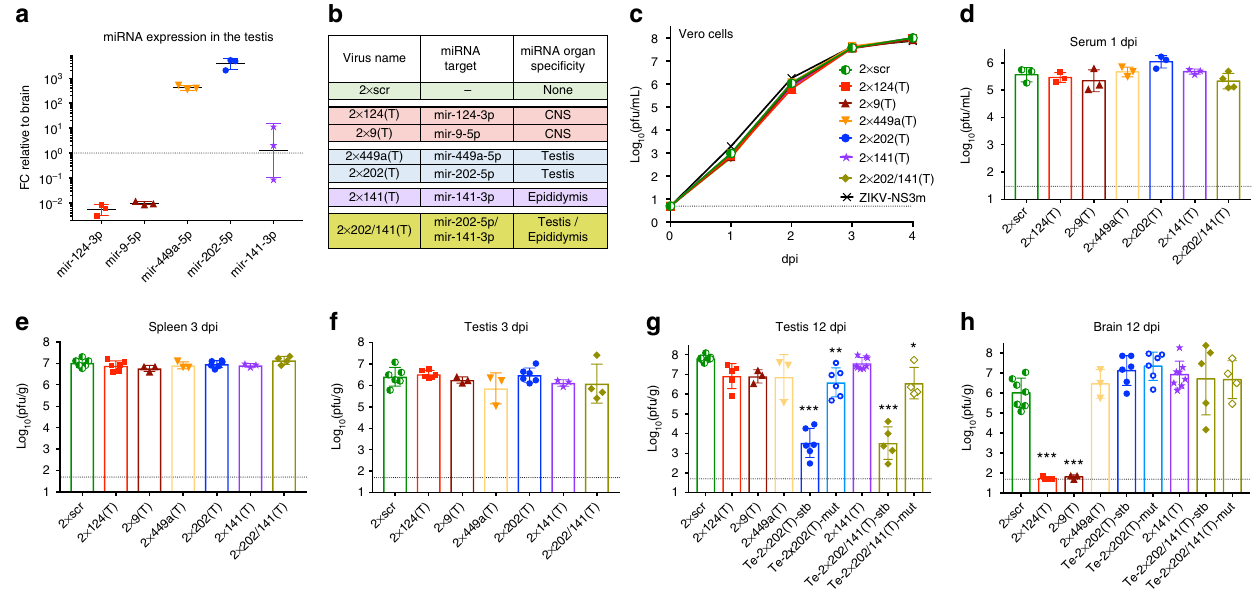
Fig. 2 Effect of miRNA target insertions on ZIKV replication in the serum and organs of AG129 mice. a Relative expression of selected miRNAs in the testis compared with their expression in the brain. Data indicate the ratio (folds change [FC]) of normalized counts for miRNAs isolated from the testis to those isolated from the brain of individual AG129 mice ( n = 3). Horizontal line and error bar are geometric mean and geometric SD, respectively. b List of viruses with inserted miRNA targets. c Growth kinetics of recombinant viruses in Vero cells. Results are presented as an average titer of two biological replicates ± SD (shown as error bars). d – h Adult AG129 mice were infected ip with 10 6 pfu of 2×scr or miRNA-targeted viruses and were killed at 3 or 12 dpi. Mean viral titer ± SD in the serum at 1 dpi d , spleen at 3 dpi e , testis at 3 dpi f, and 12 dpi g , and brain at 12 dpi h was determined by titration in Vero cells. Mice infected with 2×202(T) and 2×202/141(T) viruses were divided into two groups (stable, stb and mutant, mut) based on the miRNA target sequence stability in the testis at 12 dpi. The titers of 2×202(T) or 2×202/141(T) viruses in the brain and testis in these two groups of mice are presented separately. The dashed lines indicate the limit of virus detection: 0.7 log 10 (pfu/mL) for Vero cells ( c ), 1.5 log 10 (pfu/mL) for serum d and 1.7 log 10 (pfu/g) for spleen, brain, or testis d – h . Differences between the titer of 2×scr and the titer of each of miRNA-targeted virus in mouse serum or organs were compared using one-way ANOVA (*** p < 0.001, ** p < 0.01, * p < 0.05). Differences between the replication of 2×scr and other viruses in Vero cells were compared using two-way ANOVA, and were not statistically signi fi cant ( p >